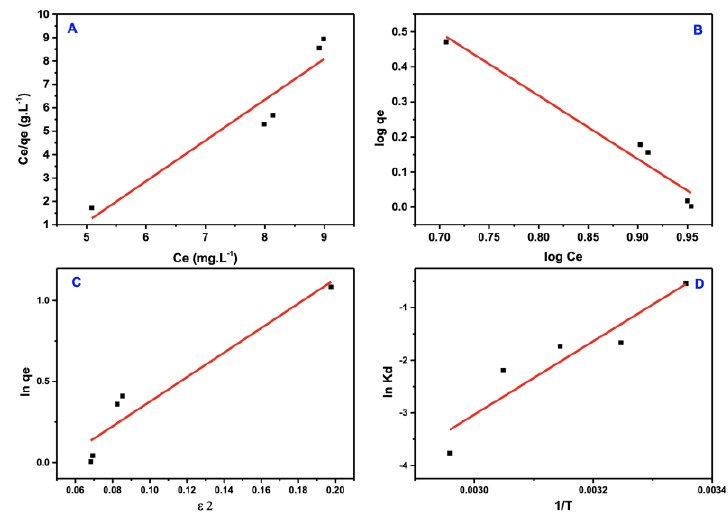
Figure 12. Isotherm models of PTZS dye adsorption. ( A ) Langmuir ( B ) Freundlich ( C ) Dubinin − Ra − dushkevich (D – R) ( D ) Arrhenius equation. Table 2. Comparison of the coefficients of isotherm for PTZS adsorption onto GO-date Seeds.